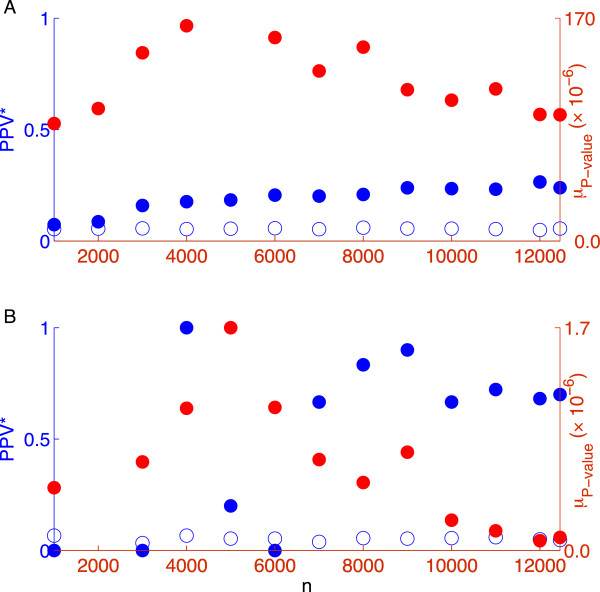
Selection measures as a function of sample size in an analysis of real height data. (A) The adjusted positive predictive value (PPV*, blue solid dots) and median P -value (μP − value, red) as a function of sample size using λ based on h2 = 0.5. Also shown is PPV* when the same number of SNPs are randomly selected rather than returned by the L1 algorithm (blue unfilled dots). (B) As in (A) but setting λ to a value appropriate for h2 = 0.01.